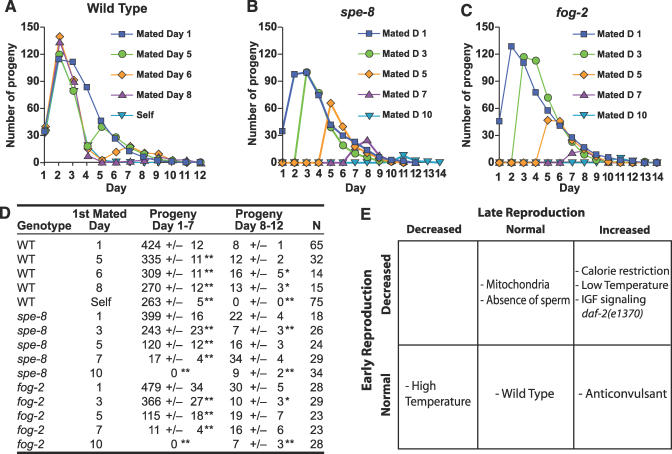
Reproductive Aging Is Independent of Early Progeny ProductionWild-type (A), spe-8(hc50) (B), or fog-2(q71) (C) hermaphrodites were mated to wild-type (WT) males for 24–48 h starting with the day specified. Graphs show daily progeny production, and (D) shows the average total progeny production (+/−standard error) for days 1–7 and days 8–12. N, the number of animals examined. * and ** represent a p-value of 0.01−0.05 and <0.01, respectively, compared to the mated day 1 value of the same genotype. (E) A summary of the effects on early and late reproduction of an anticonvulsant drug, temperature, and mutations that affect mitochondrial function, caloric intake, and IGF signaling.